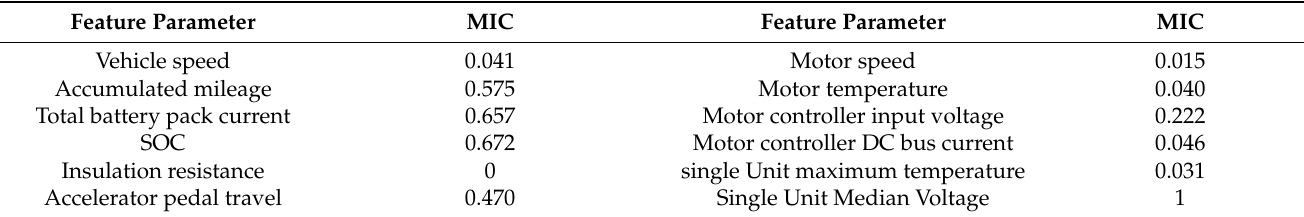
Table 4. The normalized results of MIC of